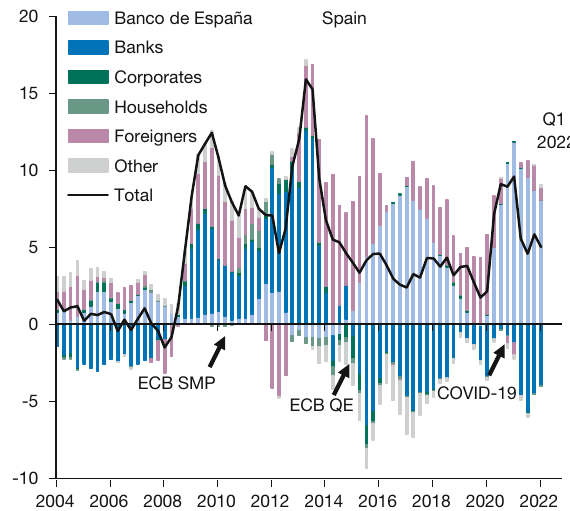
Figure 5 Issuance of Italian government bonds vs demand by sector in % GDP 4-quarter moving